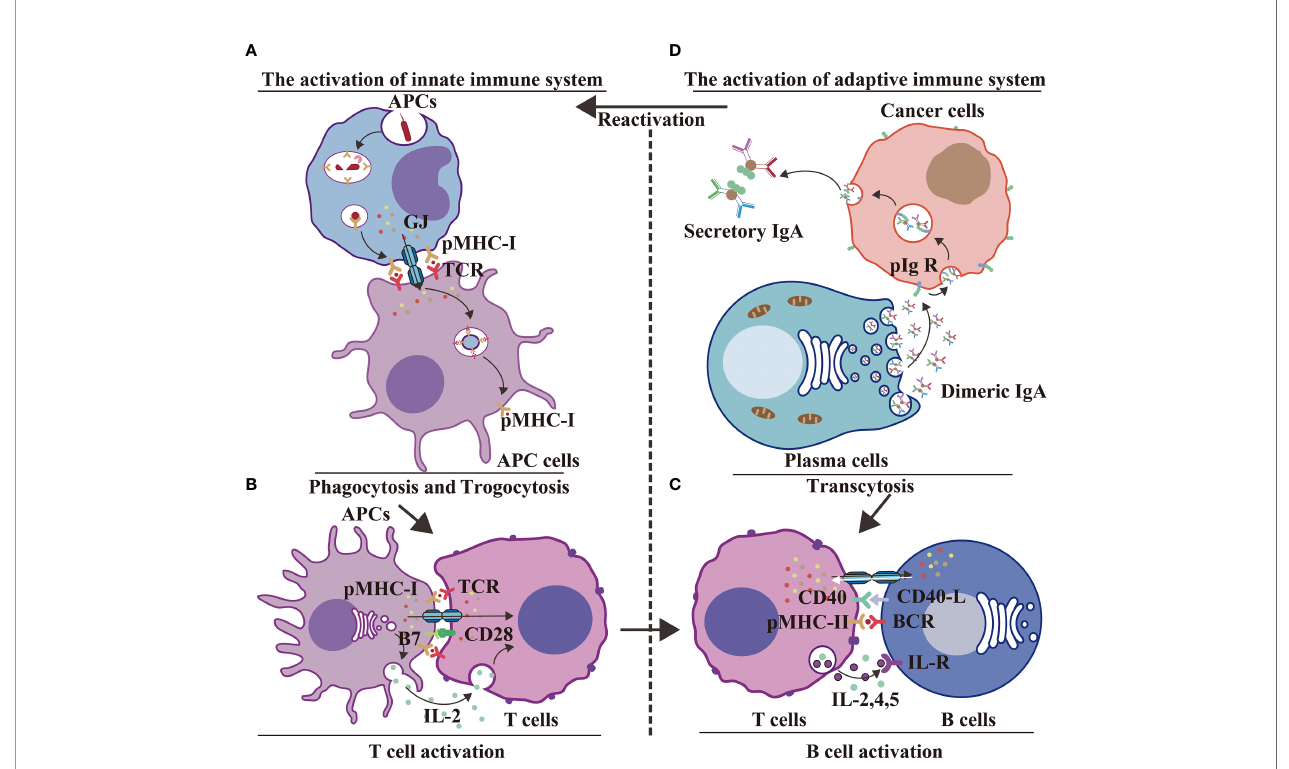
FIGURE 6 | GJs and IGLDCPs regulate phagocytosis, trogocytosis, and transcytosis during innate – adaptive immunity. (A) Innate immunity – antigen production. APCs receive pathogens and form epitopes on the membrane surface through digestion and processing of antigens. Interaction of GJs with IGLDCPs triggers phagocytosis and trogocytosis, thereby resulting in T-cell activation (14, 50). (B) Innate immunity – T-cell activation. Interaction of GJs with IGLDCPs: the former delivers Ca 2+ and ATP to T cells, whereas the latter, in contact with CD28 and facilitated by paracrine IL-2 signal transmission, activates T cells. (C) Adaptive immunity – B-cell activation. After CD4 + T-cell activation, pMHC-II establishes contact with the B-cell receptor (BCR). The resultant release of IL-2, IL-4, and IL-5 leads to B-cell activation. The adaptive immune response is jointly mediated by GJs and IGLDCPs (95). (D) Adaptive immunity – Antibodies affect pathogens. GJs activate the adaptive immune response to generate antibodies (D) . Conversely, IgA can induce APCs to activate the innate immune response via transcytosis (A) IgA can also promote B-cell activation (C) (96). HC, hemichannel; IGLDCP, Ig-like domain-containing protein; APC, antigen-presenting cell; GJ, gap